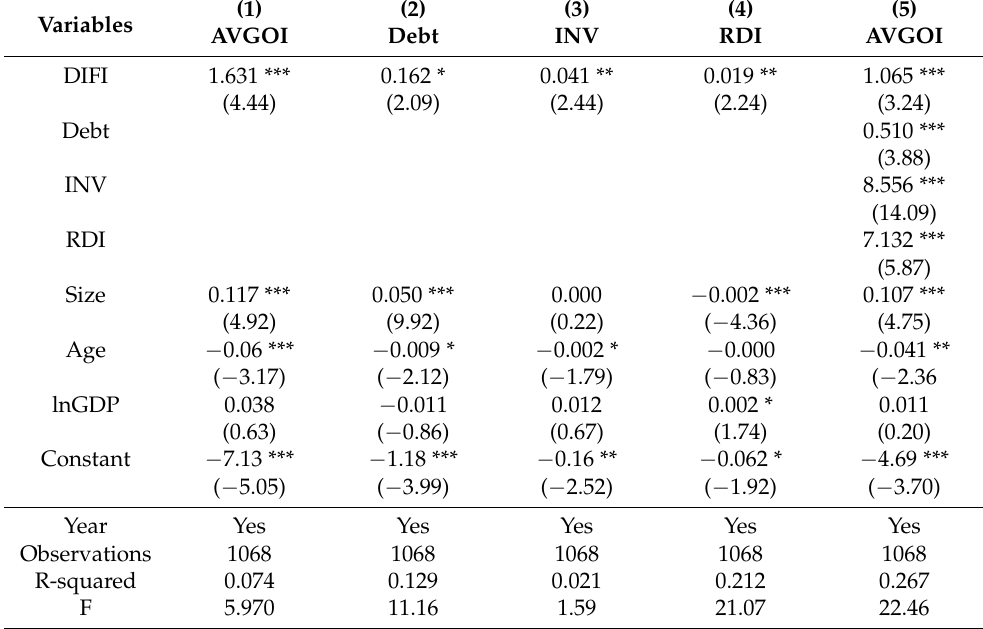
Table 6. Mediating